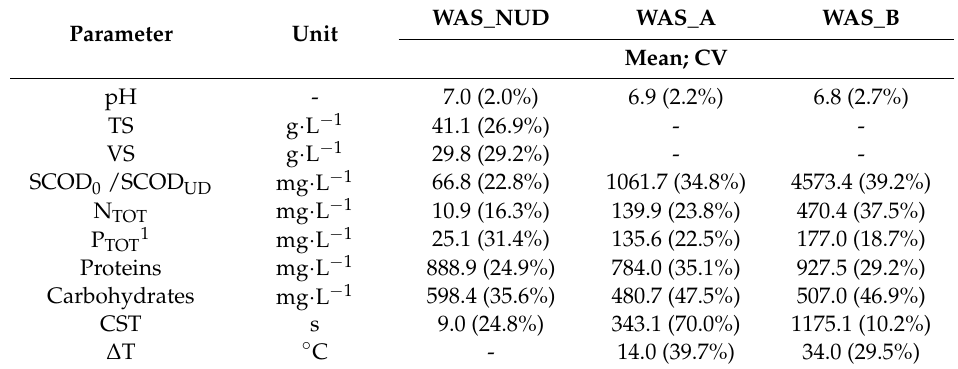
Table 4. The characteristics of the WAS before and after ultrasonic pretreatment—direct effects (n =